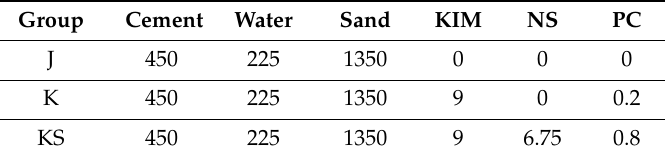
Table 4. Mix proportion of cement mortar (g).